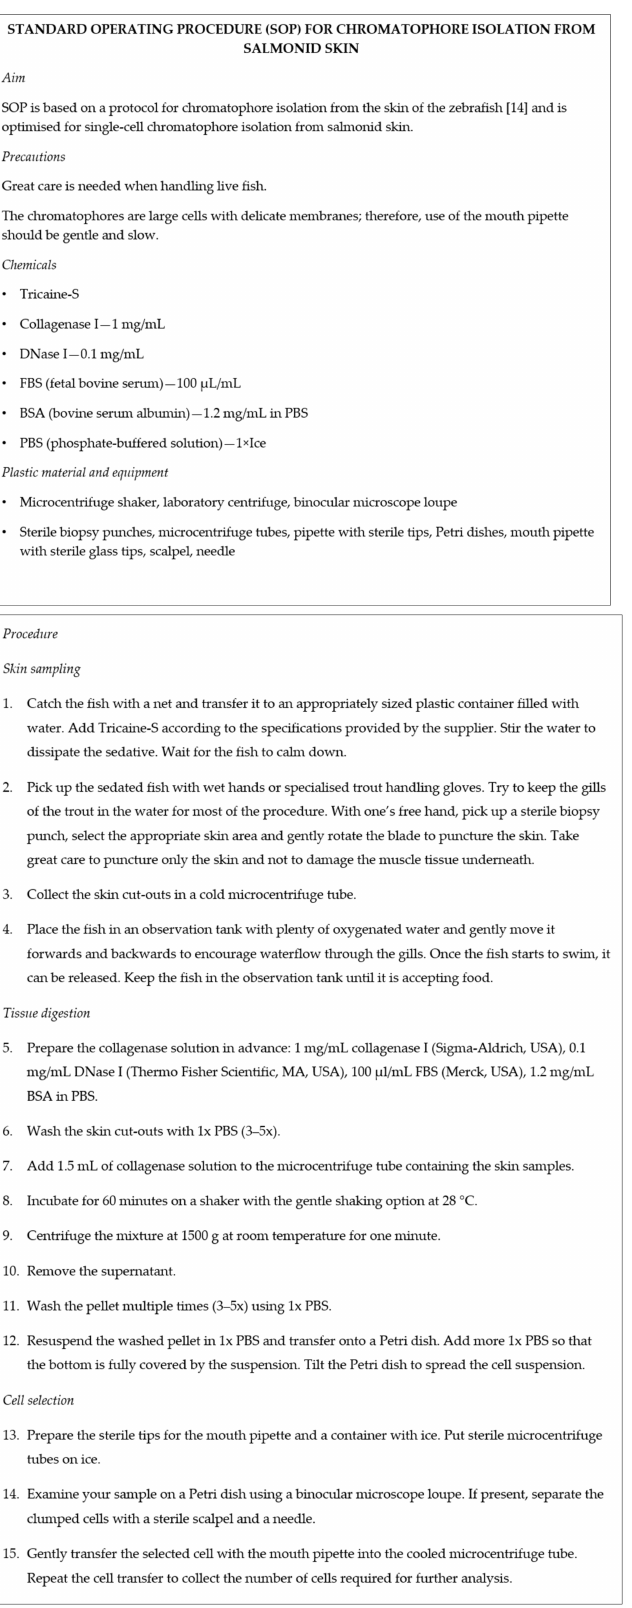
Figure 6. Final protocol for single-cell suspension preparation and single-cell (e.g., chromatophore) isolation from brown trout